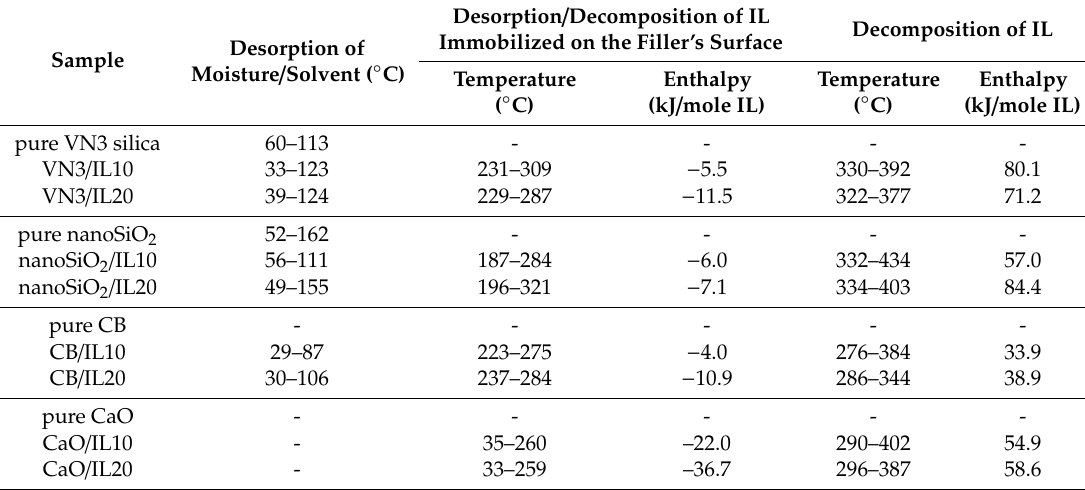
Figure 10. DSC curves for pure and DmiBr-modified nanosized CaO (exoˆ). Table 6. DSC analysis for pure and modified